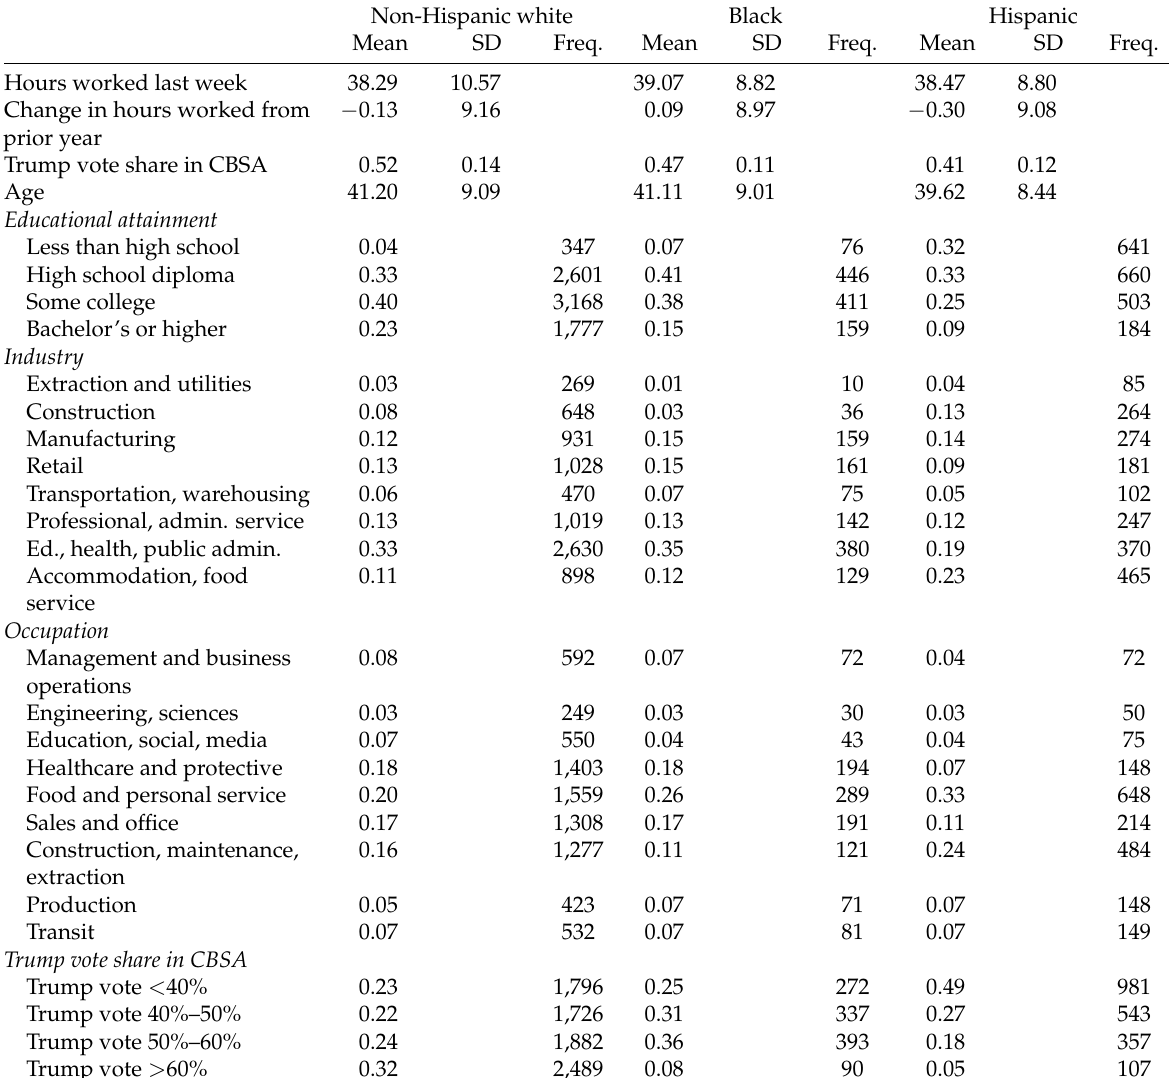
Table 1: Unweighted descriptive statistics of analytic sample, by race Non-Hispanic white Black Hispanic